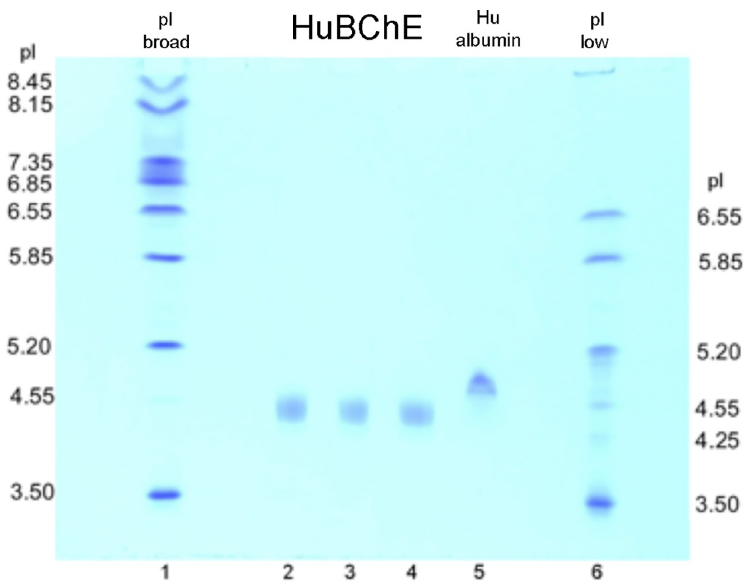
Fig 11. Isoelectric focusing polyacrylamide gel for 3 preparations of HuBChE and for human albumin. Calibration standards are in lanes 1 and 6. Pure HuBChE samples 1 μ g each, are in lanes 2, 3, and 4. Human albumin is in lane 5. HuBChE has pI